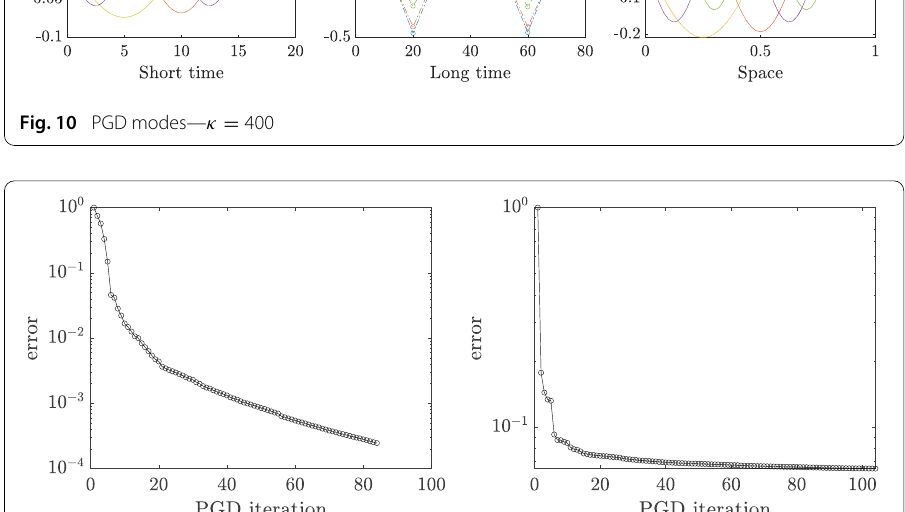
Fig. 11 Error decay for successive PGD enrichments for κ = 100 (left) and κ = 500 (right)